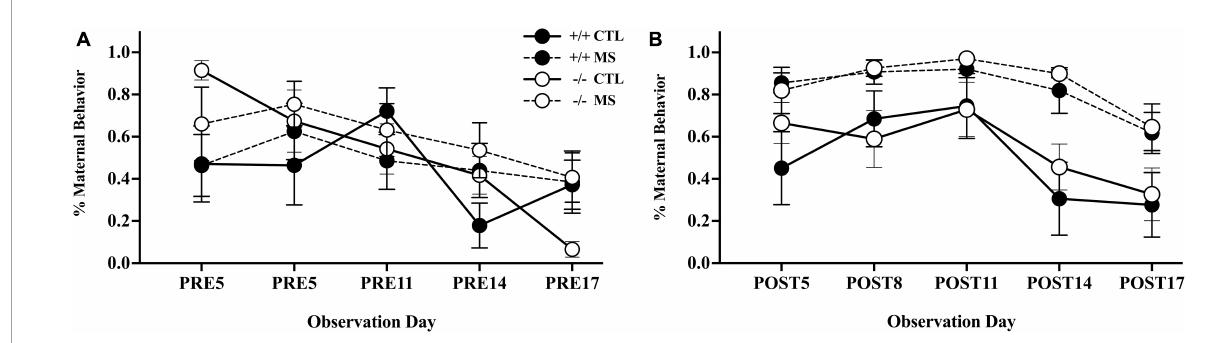
FIGURE2 Maternal behavior pre- (A) and post- (B) separation, in control (CTL) or maternally separated (MS) litters of both genotypes. All litters were assessed twice over 10 mins on 5 days: PND 5, 8, 11, 14, and 17). The first assessments on each day are shown in panel (A) indicating no differences in pre-separation maternal behaviors between genotypes, or experimental groups. As expected, panel (B) shows an increase in maternal interactions in separated litters, an effect that did not differ between genotypes. Symbols represent the mean ± SEM percentage of time dams were engaged in maternal care in 30 litters (15 of each genotype). Please consult text for full experimental details and results.